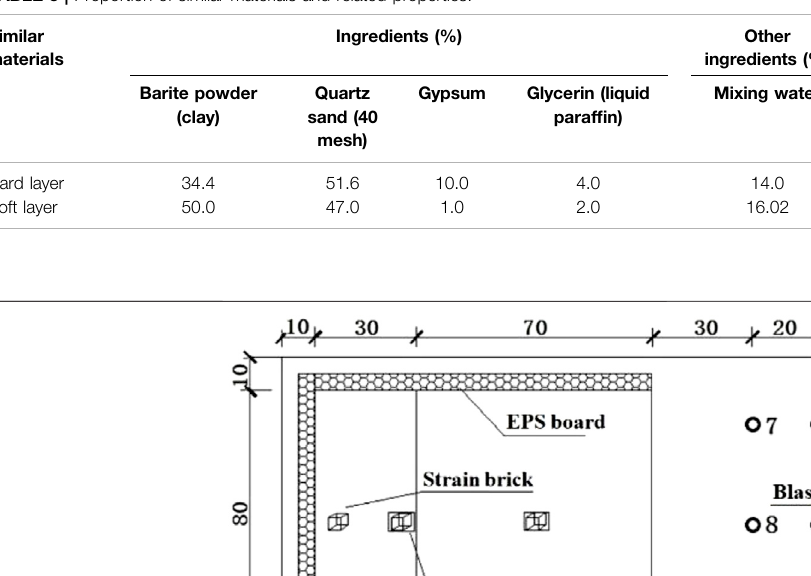
TABLE 3 | Proportion of similar materials and related properties.